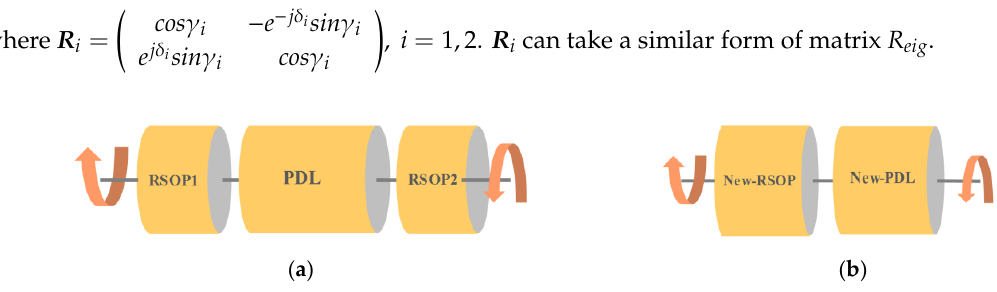
Figure 3. ( a ) The generalized polarization model in fiber; ( b ) the simplified polarization model.